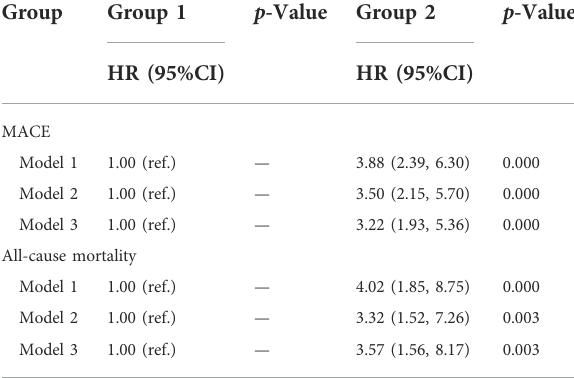
TABLE5HRsand95%CIsofclinicaloutcomesaccordingtomedianof serum Cys-C. Group